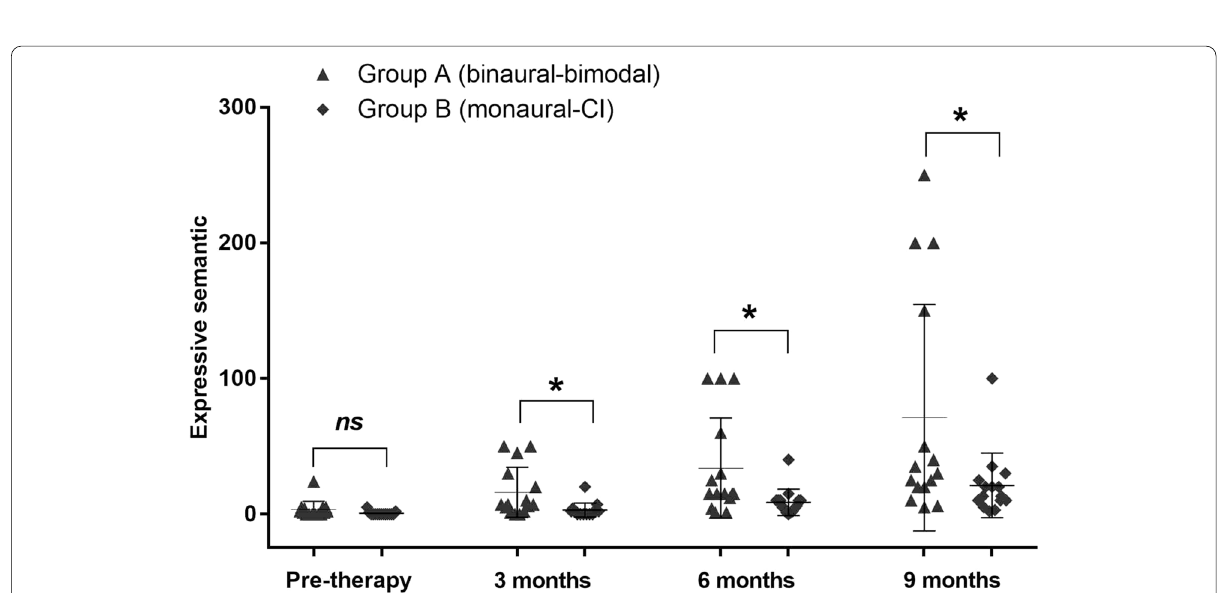
Fig. 2 Comparison of the expressive semantics between group A and group B. Results of unpaired t ‑test (two tailed) revealed better performance in group A (bimodal) over time. CI, cochlear implantation; ns, nonsignificant, *significant ( P <